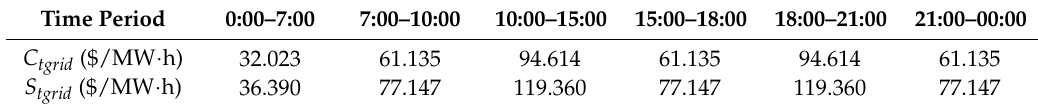
Table 10. Electricity exchange price of microgrid and the public grid.